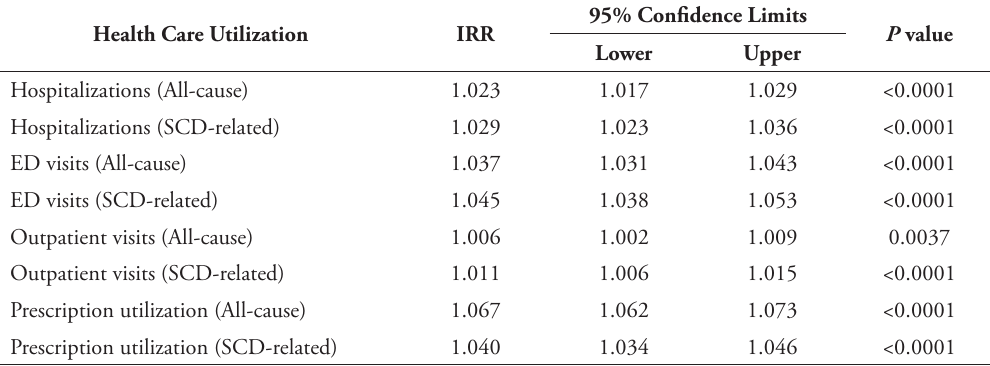
Table 6. Results of Negative Binomial Regression Analyses Examining the Association Between the Number of Opioid Prescriptions and Health Care Utilization among Patients with SCD (N =